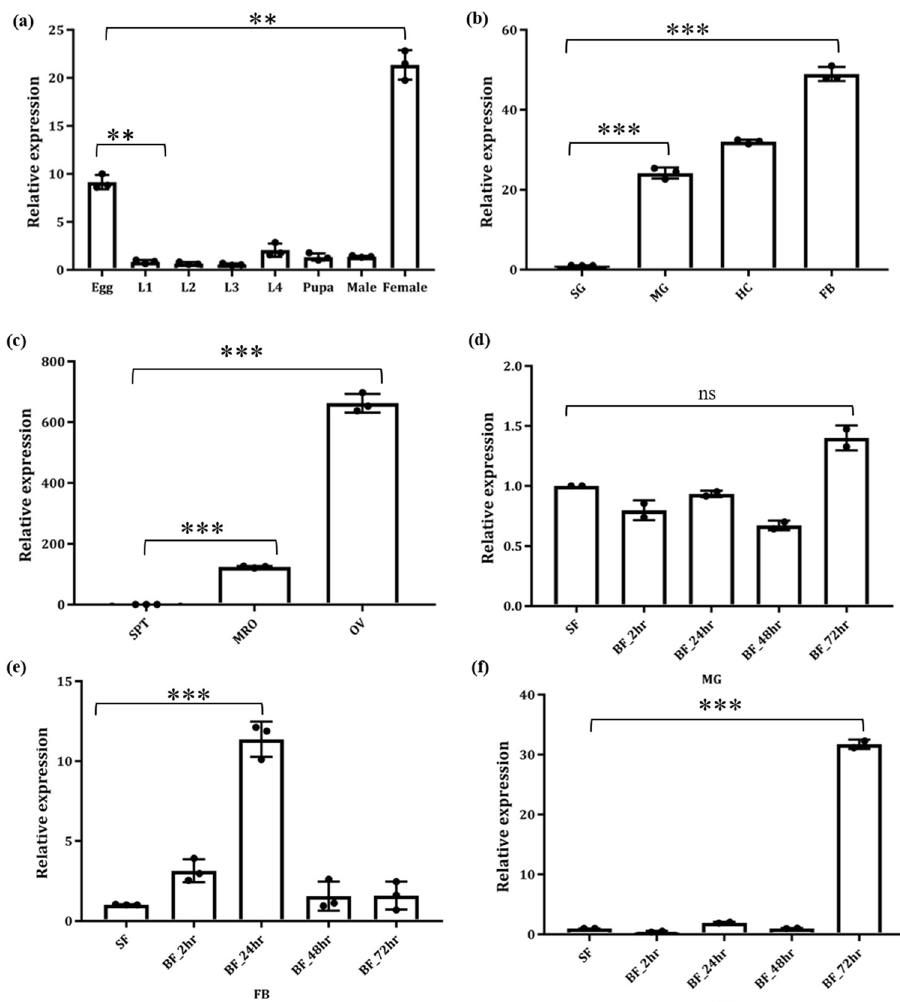
Fig 3. Spatial-Temporal expression profiling of AcTrf1a in the mosquito An . culicifacies (a) Relative gene expression during mosquito development, showing an abundance of AcTrf1a transcript in the eggs (p < 0 . 0018) and adult female mosquito (p < 0 . 0045) . The first instar larval stage was considered as a control for all test samples. L1-4 (larval stages) (n = 10, N = 3); (b) Expression analysis in the adult female mosquito tissues showing multi-fold upregulation of AcTrf1a in fat-body (FB/ p < 0 . 0001 ), hemocytes (HC/ p < 0 . 0001 )and midgut (MG/ p < 0 . 0019 ) respectively. Data were analysed relative to salivary gland (SG) (n = 25, N = 3); (c) AcTrf1a mRNA levels profiling in the mosquito reproductive tissues shows a prolific expression in the ovary (OV/ p < 0 . 0003 )and male reproductive tissue (MRO/ p < 0 . 0001 ). Female spermatheca was set as a control for relative analysis (n = 20, N = 3); (d) Tissue-specific transcriptional response of AcTrf1a after blood-feeding: mosquito tissues such as midgut, fat-body, and ovary were collected at 2, 24, 48, and 72 hr post blood meal (PBM) and compared with sugar-fed na ï ve female as a control (n = 25, N3). AcTrf1a mRNA is minimally expressed in the blood-fed midgut (ns); (e) moderate in fat-body ( p < 0 . 0003 ) post 24 hr of blood meal, and (f) highest in 72 hr PBM ovary ( p < 0 . 0005 ). All the three independent biological replicates are shown using dots and statistical analysis was performed by one-way ANOVA where asterisks represented � p < 0.05; �� p < 0.005; and ��� p < 0.0005, ( n = represents the number of mosquitoes pooled for sample collection; N = number of replicates). highly upregulated within two hrs of the bacterial challenge. Together, these observations fur- ther strengthen the hypothesis that AcTrf1a has an antibacterial role in mosquito An . culicifacies .